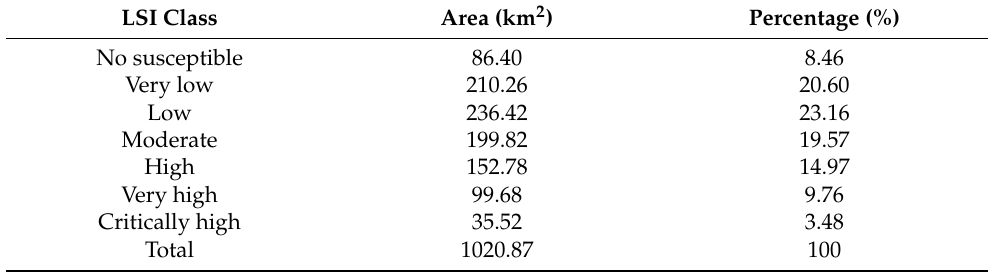
Table 6. Areas of susceptibility map classes.